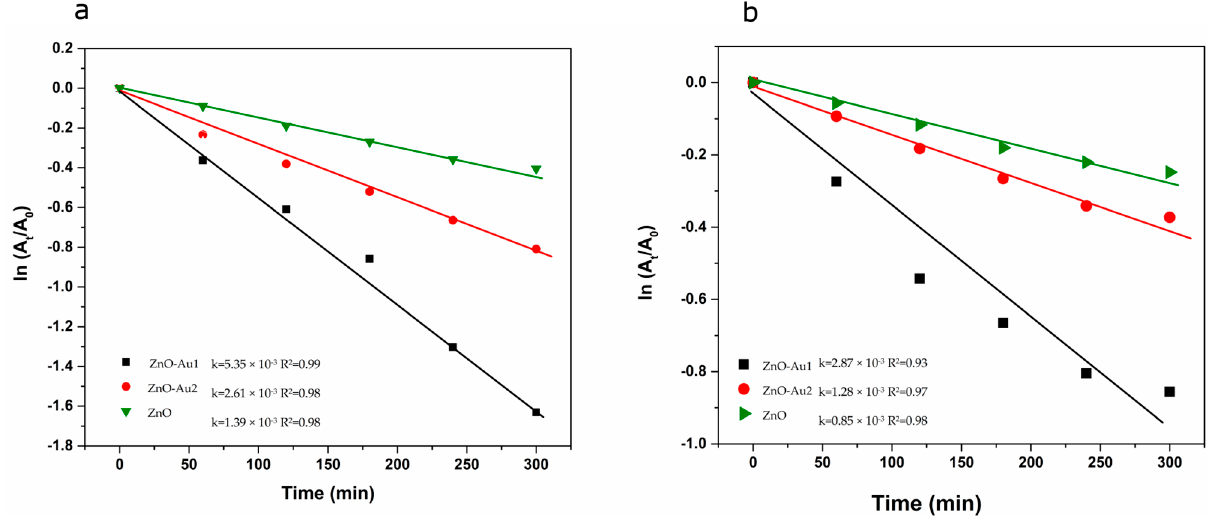
Figure 12. Evaluation of the photodegradation kinetic of ( a ) RhB and ( b ) OTC in the presence of ZnO nanoparticles, respectively, ZnO-Au1 and ZnO-Au2 nanocomposites.